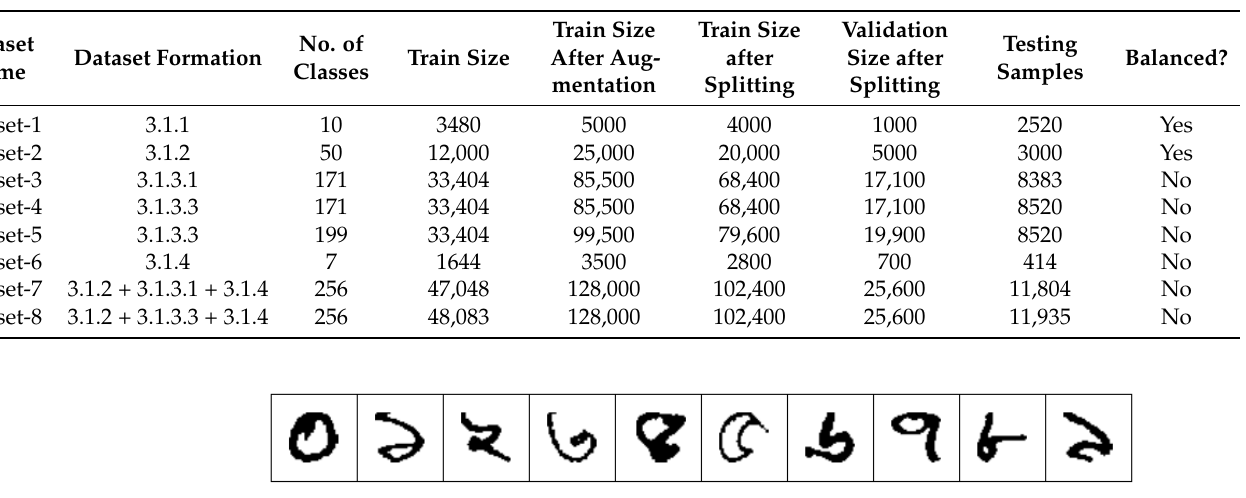
Figure 1. Bengali Numerals Samples from CMATERdb Dataset.